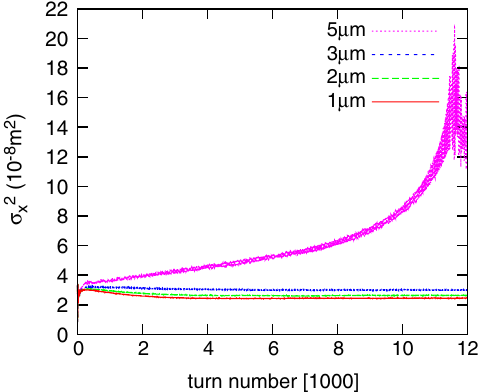
FIG. 3. Simulated rms beam size of the electron beam distri- bution versus turn number for different noise amplitudes, clearly revealing the existence of a threshold for the onset of the instability.